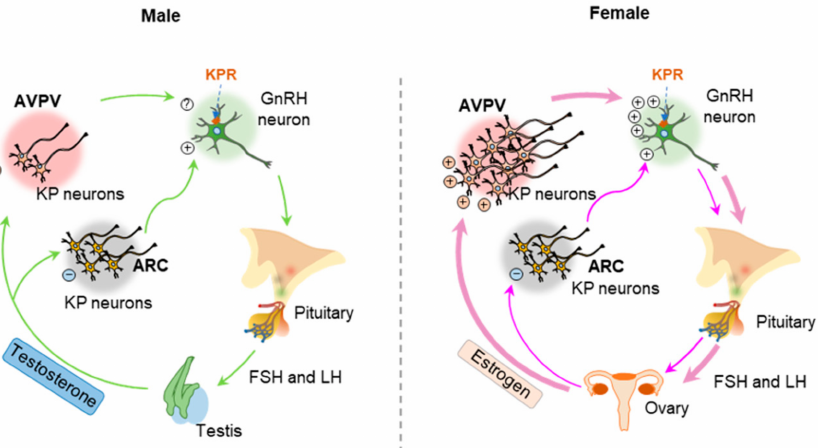
Figure 6. Sexual dimorphism in hypothalamic kisspeptins. Kisspeptin (KP) neurons are located in two major regions: the arcuate (ARC) nuclei, and the anteroventral periventricular and periven- tricular preoptic nuclei (AVPV/PEN). KPR are expressed on the GnRH neurons. KPs expressed in hypothalamic nuclei are crucial for the onset of puberty, gonadal development, and maintenance of reproductive functions. Sex-specific differences in the numbers of KP neurons and the KP expression levels exist in the hypothalamus. KP neurons in ARC nuclei generate pulsatile GnRH secretion, while those in the AVPV nuclei induce the preovulatory gonadotropin surge (thick line). GnRH neurons, found near the pituitary gland, is innervated by the KP neurons of ARC and AVPV origins. While the KP expression in the ARC nuclei is similar between males and females, KP expression is highly dimorphic in the AVPV nuclei due to greater numbers of KP neurons in females. Thin lines stand for lower levels and thick lines stand for higher levels of